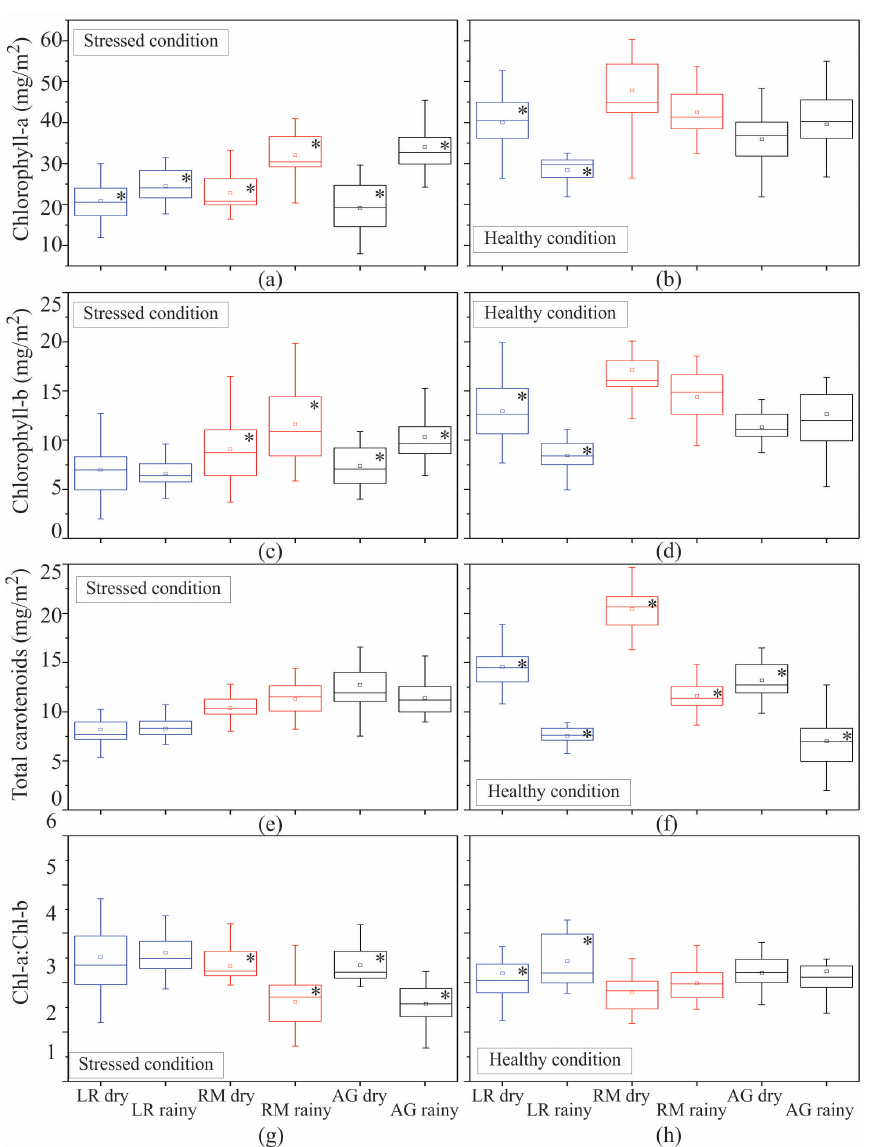
Figure 4. Chlorophyll-a, chlorophyll-b, total carotenoids, and the chlorophyll a/b ratio box plots for the six classes of mangroves during the dry and rainy seasons. Each box plot depicts the mean (small square), the 25%–75% quartiles (rectangle), and the median (line dividing the box plot): LR: Laguncularia racemosa , RM: Rhizophora mangle , AG: Avicennia germinans . An asterisk indicates a seasonal significant difference at p < 0.05, based on the Mann–Whitney U -test. ( a ) Chlorophyll-a stressed condition; ( b ) chlorophyll-a healthy condition; ( c ) chlorophyll-b stressed condition; ( d ) chlorophyll-b healthy condition; ( e ) total carotenoids stressed condition, ( f )total carotenoids healthy condition; ( g ) chlorophyll a/b ratio stressed condition; ( h ) chlorophyll a/b ratio healthy condition.